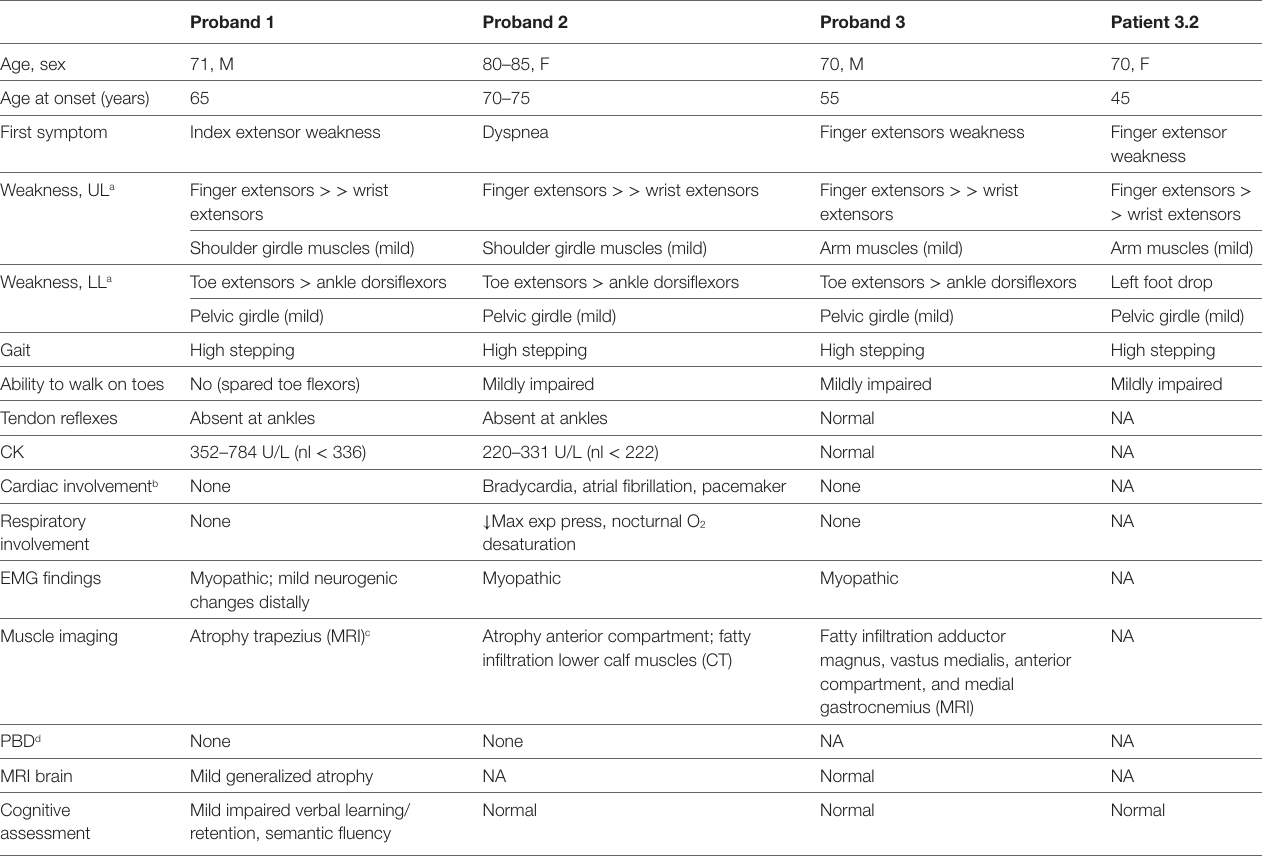
TaBle 1 | Clinical and laboratory findings of subjects carrying both the TIA1 and SQSTM1